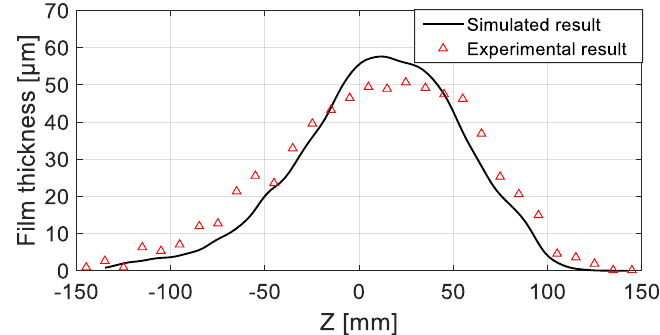
Figure 17. Planar tilted spraying: comparison of experimental and simulated coating film thickness distribution in the plane X = 0.